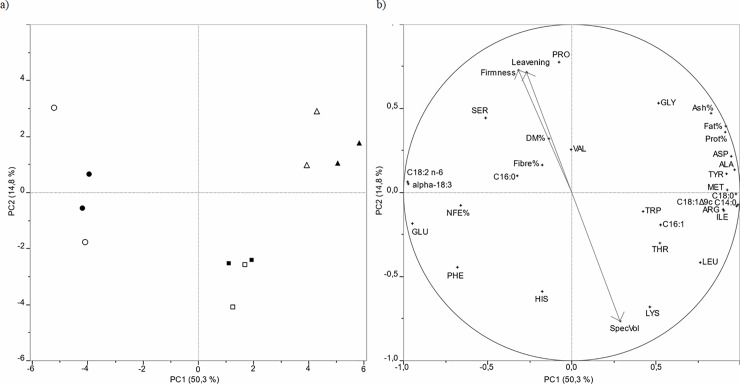
PCA scores plot of bread samples (panel a) and PCA loadings plot of variables (panel b). Loading vectors of technological variables (Specific volume, Leavening, Firmness) are highlighted. Amino acid composition data were expressed as relative percentages. Samples: ● = WB, ○ = WBS; ▀ = MB5; □ = MBS5;▲ = MB10; Δ = MBS10. Samples are codified as reported in Table 1.